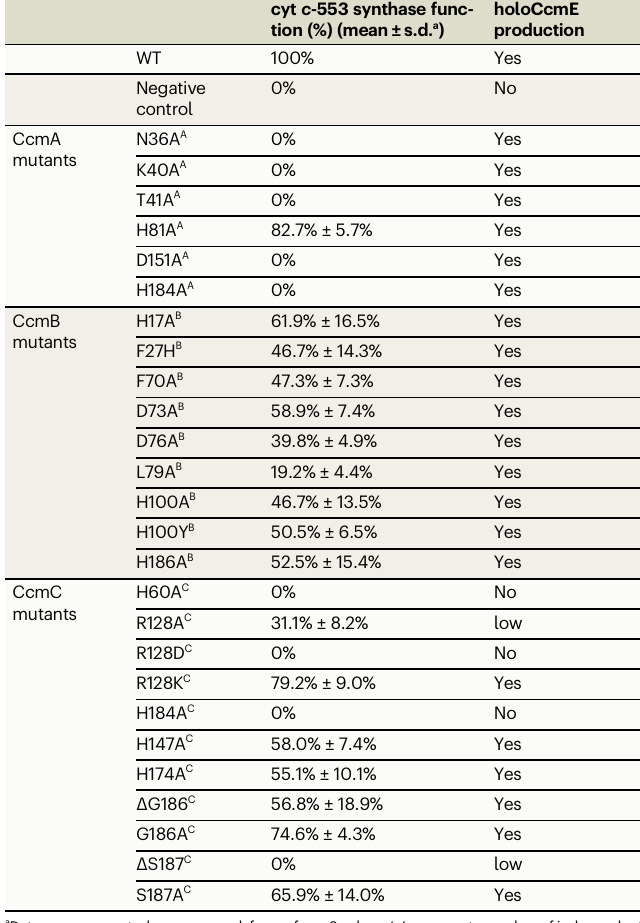
Table 1 | In vivo activities of